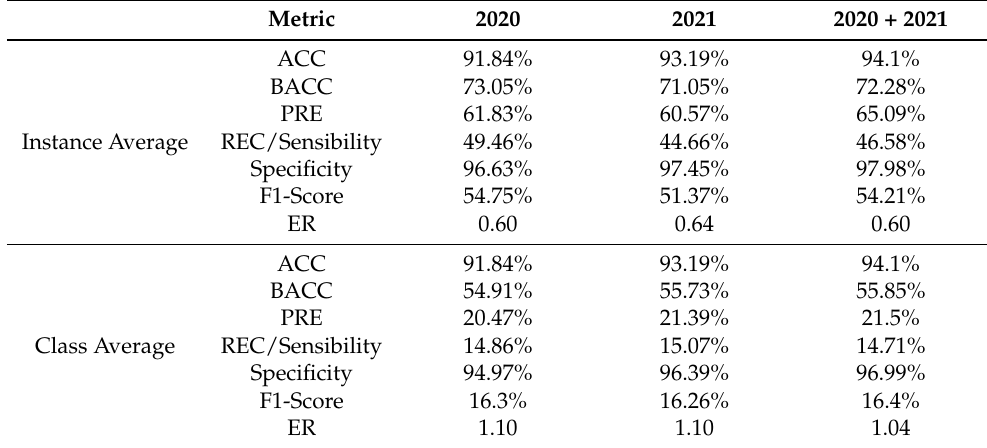
Table 4. Summary of Metrics assessing the classification performance for the 2020 campaign, the 2021 campaign and both campaigns